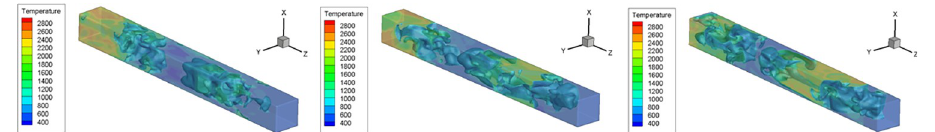
Fig 25. Temperature isosurface at different gas concentrations at 100 ms(5%; 9.5%; 16%).